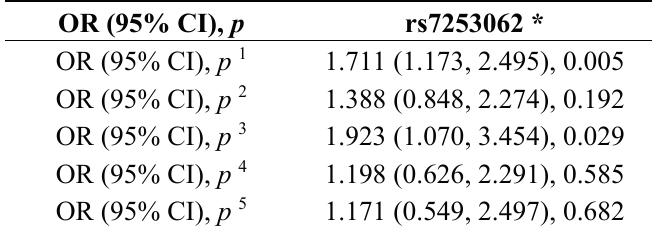
Table 4. Risk estimated based on the multiple stepwise adjustment in rs7253062.